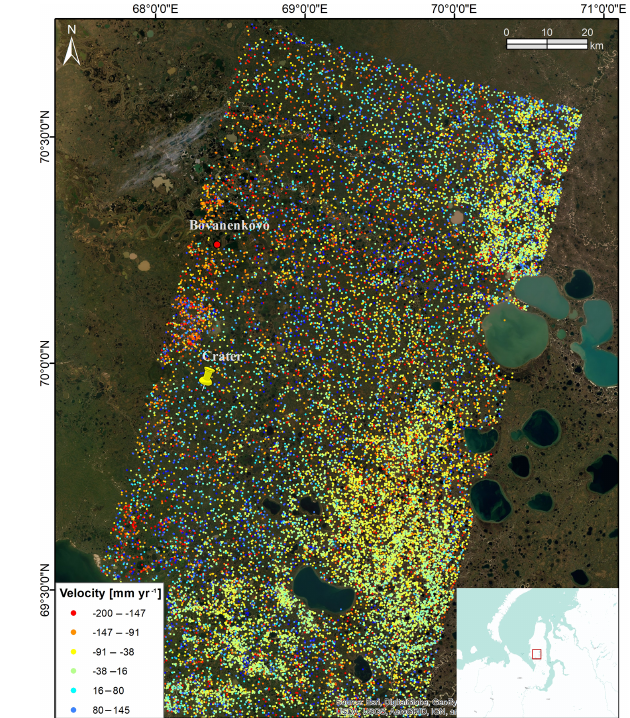
Figure 2. Hotspot cluster kernel-density map showing smoothed spatial location of clusters in zones A, B and C. Analysis highlights areas of spatially correlative regions as high kernel-density values in blue. Hotspot analysis was performed on results of PS InSAR analysis (Fig.